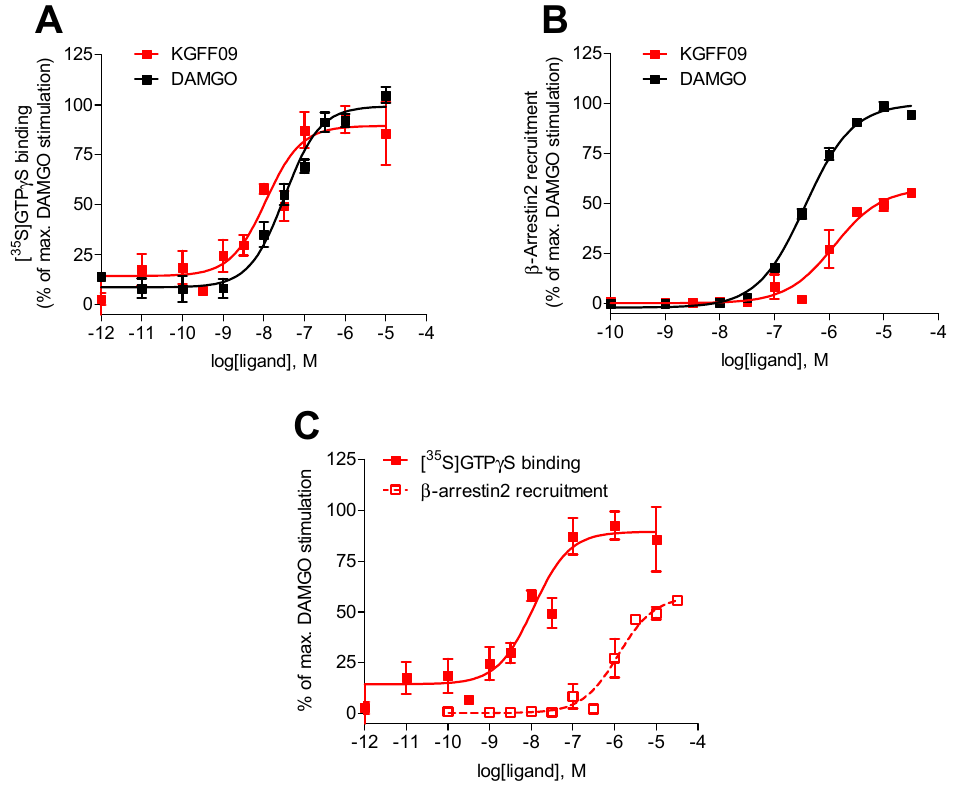
Figure 2. In vitro functional profile of KGFF09 at the human MOR. Concentration-response curves of agonist-stimulated ( A ) G protein activation (the [ 35 S]GTP γ S binding assay) and ( B ) β -arrestin2 recruitment (the PathHunter β -arrestin2 assay) at the human MOR by KGFF09 and DAMGO. ( C ) Comparison of G protein activation (the [ 35 S]GTP γ S binding assay) and β -arrestin2 recruitment (the PathHunter β -arrestin2 assay) at the human MOR by KGFF09 . Values represent the mean ± SEM ( n = 3).